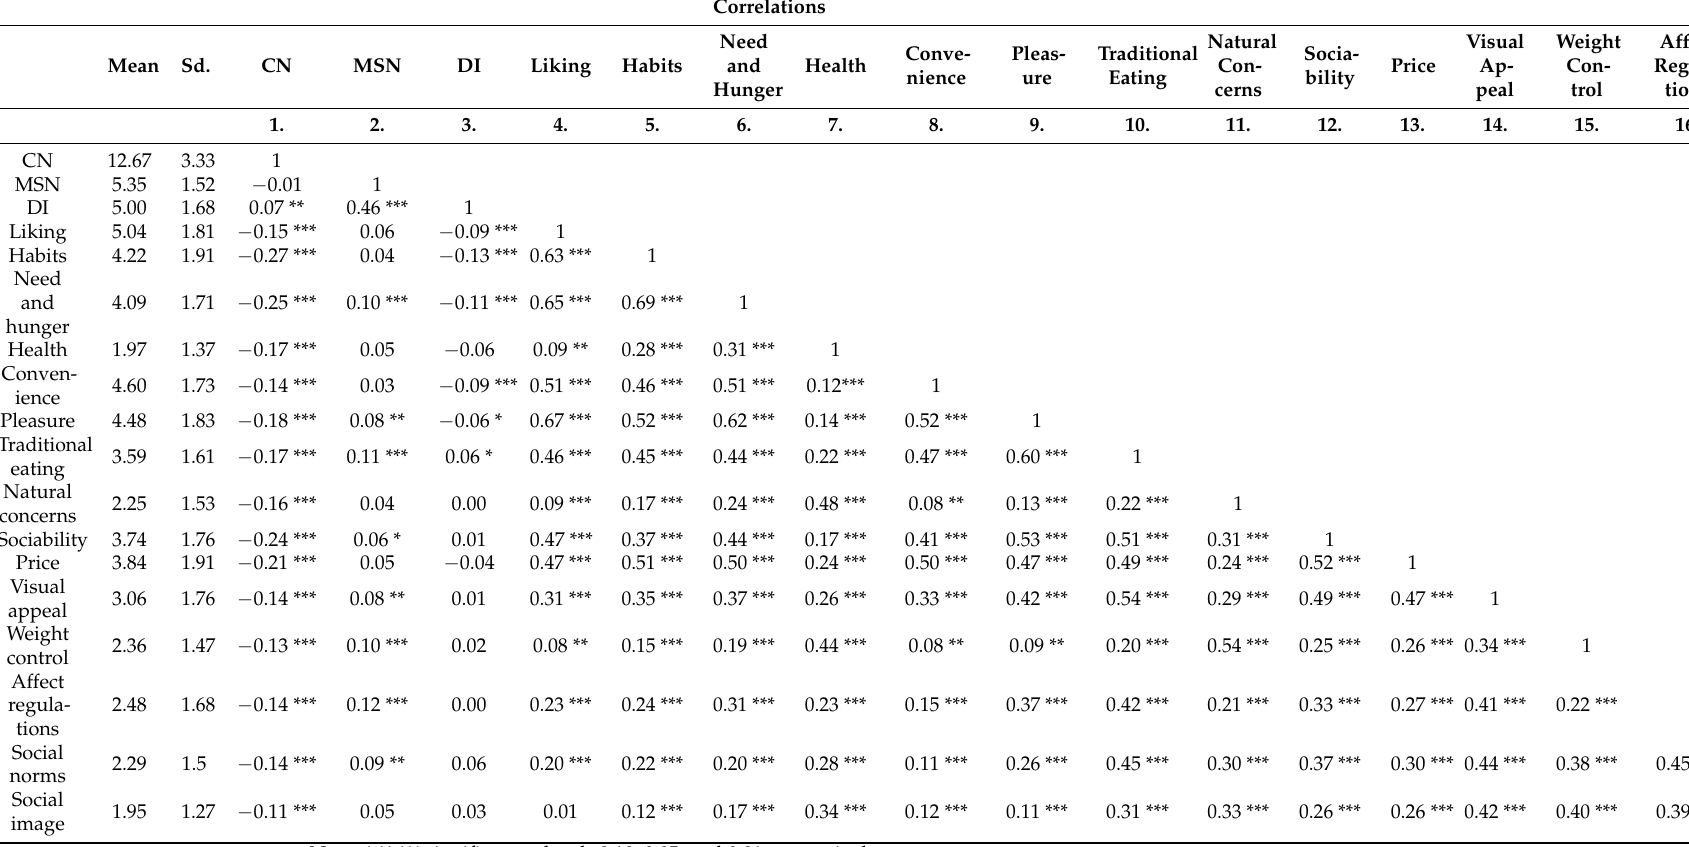
Table 1. Mean, standard deviation, and Pearson’s correlation between determinants and intention to discard ( n = 807).